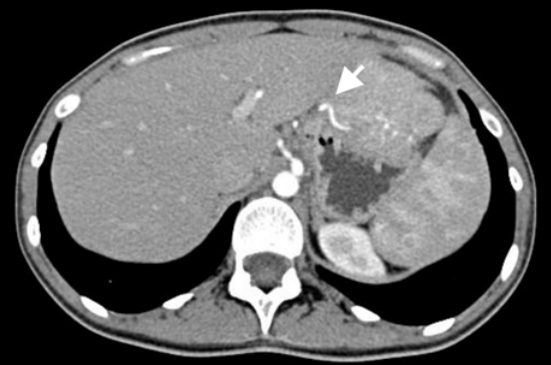
Figure 3. Hepatic arterial phase CT scan. The mass of about 7 cm in diameter exerts compression on the stomach.